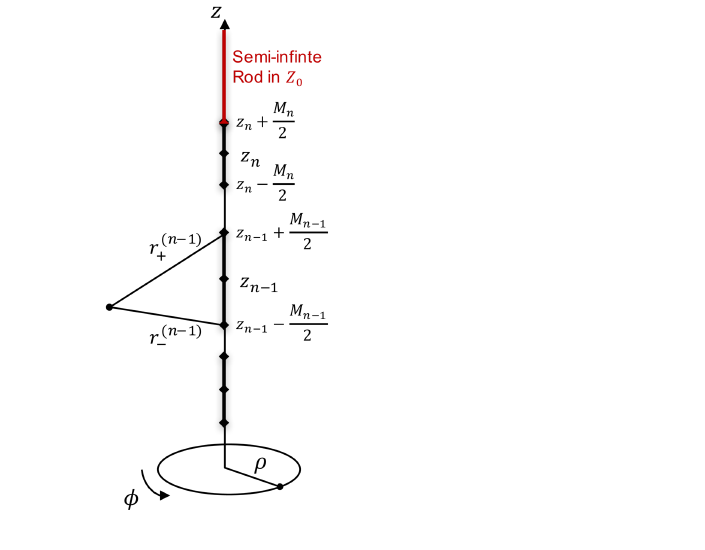
Figure 4 . Schematic description of axisymmetric rod sources with a semi-infinite rod in Z 0